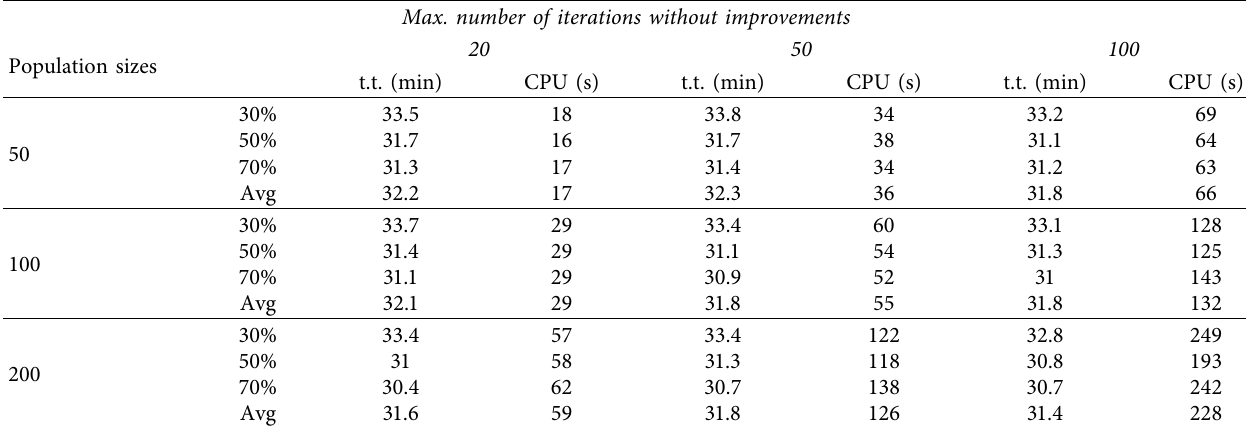
Table 4: Sensitivity analysis of the MA for a population of 50, 100, or 200 solutions and the stop condition without improvements of the best solution for 20, 50, and 100 iterations. Results show the passenger travel time (t.t.) and the computation time